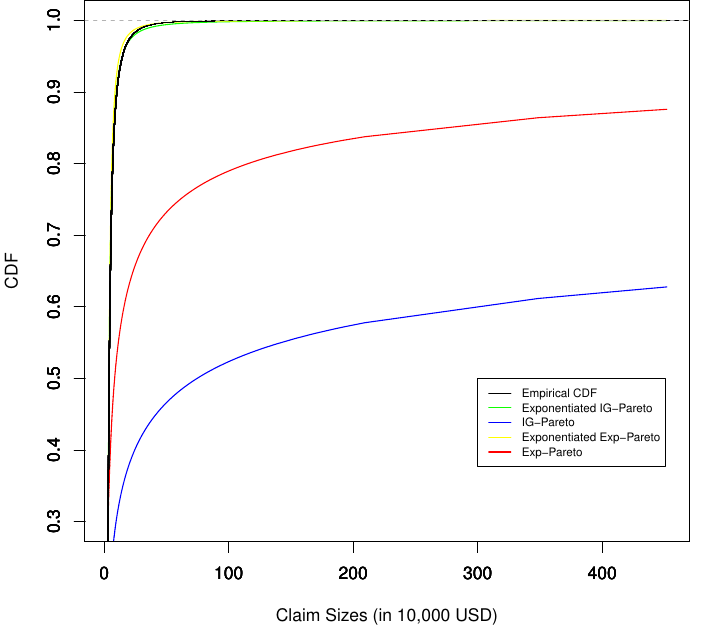
Figure 11. The empirical CDF of SOA group medical claims data and the fitted CDF of corresponding exponentiated IG-Pareto, IG-Pareto, exponentiated exp-Pareto, and exp-Pareto model